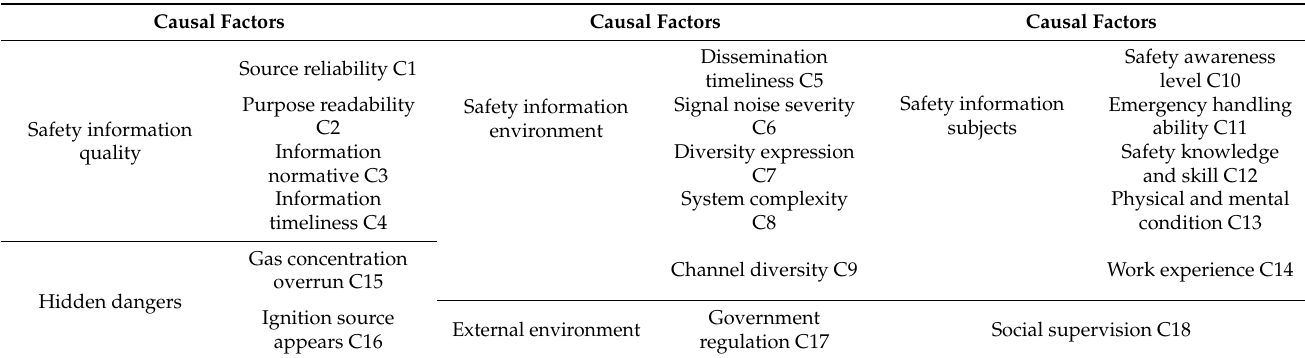
Table 1. Causal factors of gas explosion